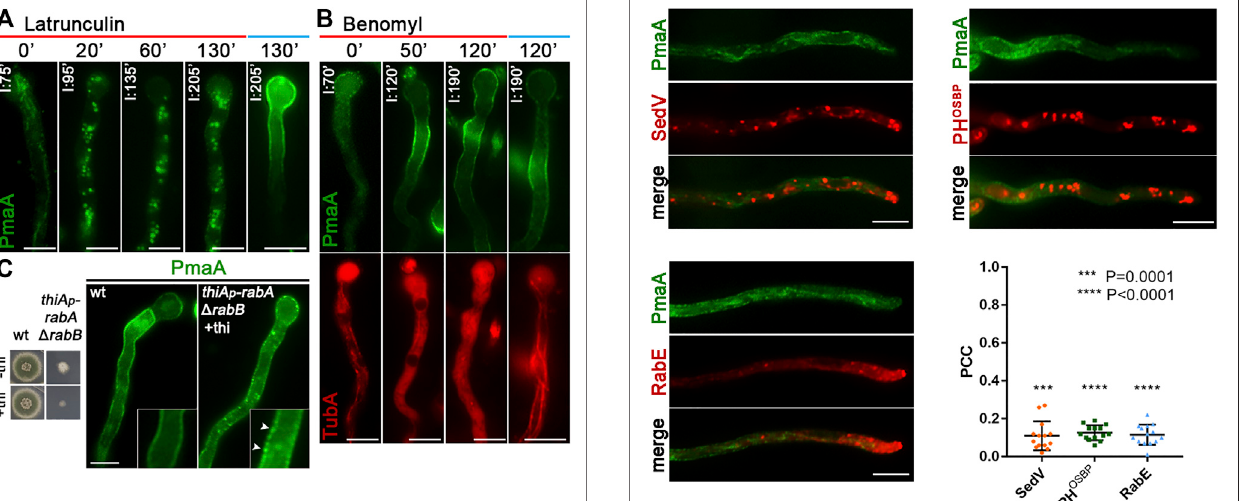
FIGURE 4 | Role of actin, tubulin, or Rab5 endosome function in PmaA subcellular localization. (A) Time course of treatment with the actin polymerization drug latrunculin B for 0 – 130 min of a strain expressing neosynthesized PmaA-GFP under conditions of derepression compared to an untreated strain included as control. In all cases, latrunculin B was added at 75 min of PmaA derepression so that the total time of PmaA- GFP expression was 75 – 230 min in the different samples. It is noted that PmaA fails to reach the PM when latrunculin is present in the medium, in contrasttothecontroluntreated strain. (B) Timecourseoftreatmentofstrains expressing neosynthesized PmaA-GFP and mCherry-TubA with benomyl for 0 – 120 min. The anti-microtubule drug was added at 70 min of PmaA derepressionsothatthetotaltimeofPmaA-GFPexpressionwas70 – 190 min. Depolymerization of microtubules upon treatment with benomyl was evident by the diffused cytoplasmic signal of mCherry-TubA. It is noted that, in this case, PmaA normally reaches the PM. (C) Localization of newly synthesized PmaA-GFP in the absence of both RabA and RabB. rabA transcription is ab initio repressed(o/n) via thiamine,while rabB isgeneticallydeleted.Thedouble knockout/knockdown strain fails to form a proper colony in the presence of thiamine, as seen in the growth test on the left. It is noted that PmaA localization to the PM is not affected by the absence of proper endosomal functioning. Scale bars: 5 μ m.